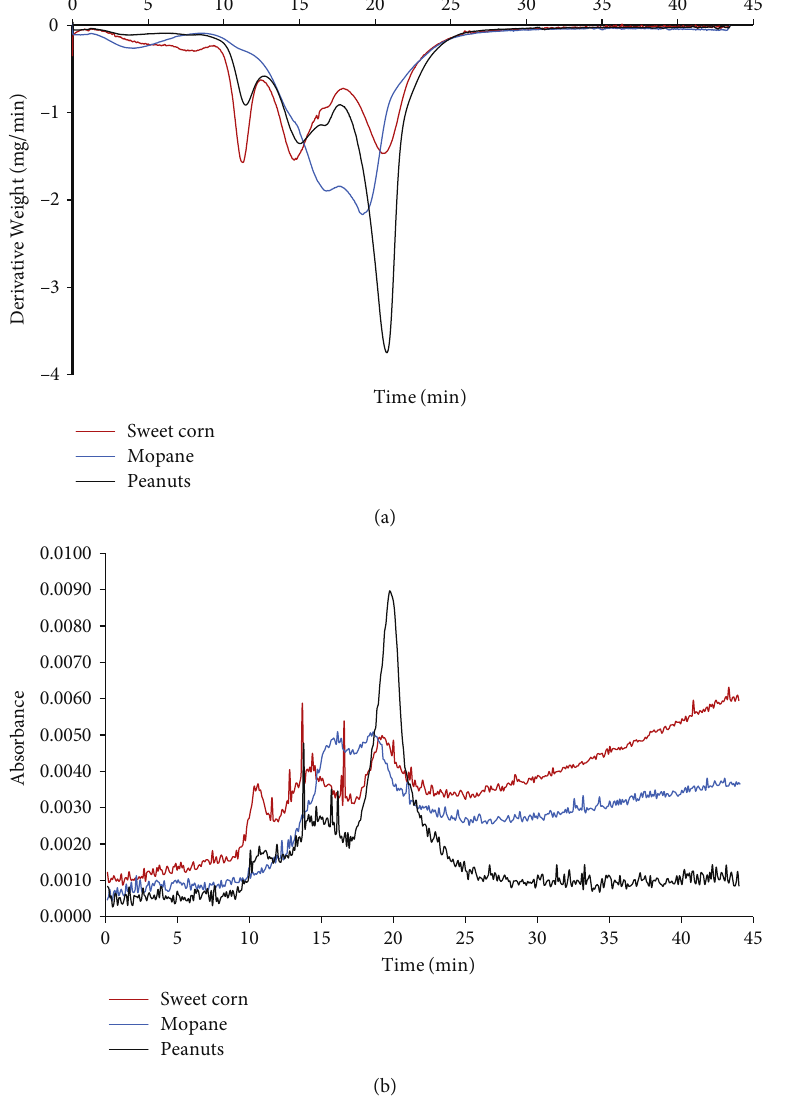
Figure 3: (a) dTGA curves and (b) evolution pro fi le of the degradation products of sweet corn, mopane worm, and peanut